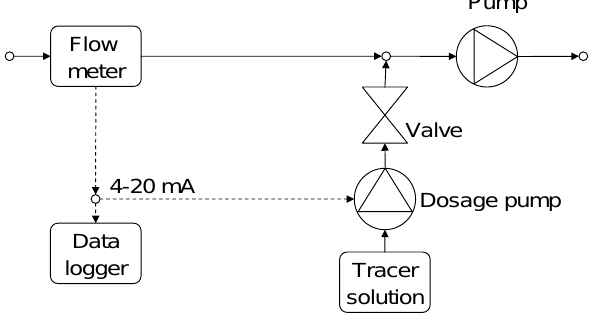
Figure 2. Measurement setup for adding tracer